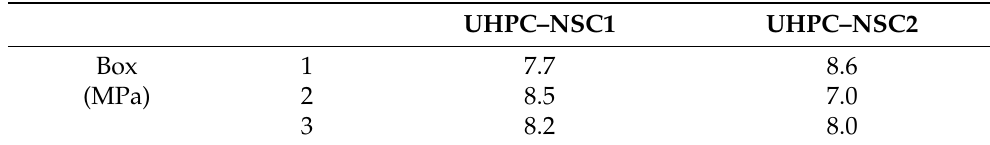
Figure 9. Box sample in the hydraulic loading machine during testing after the crack occurred. Table 4. Shear strength of the box